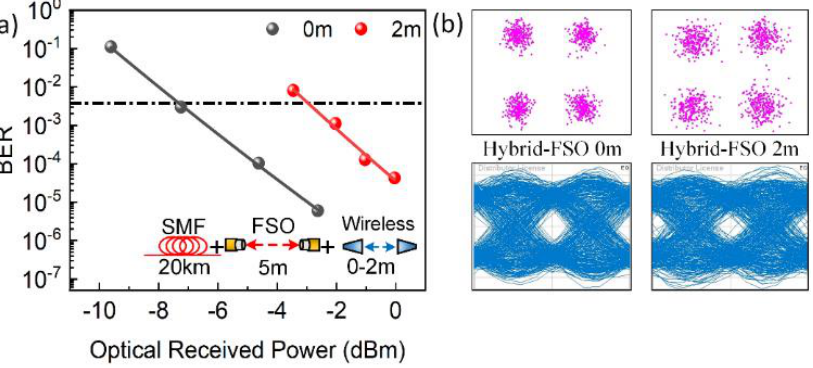
Figure 6. ( a ) BER versus received optical power of the QD-DWL source at 30 GHz for the hybrid-FSO channel with 0- and 2-m WL link lengths. ( b ) The corresponding received QPSK constellation (top) and eye diagram (bottom) at a ~−1.0 dBm received power for 0-m (left column) and 2-m (right column) WL link lengths.